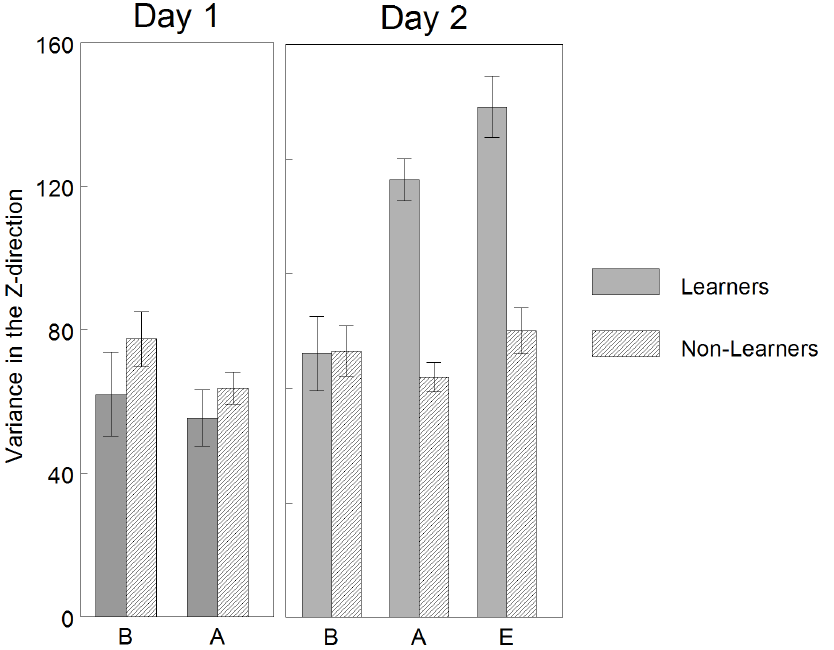
Figure 7. Learners versus non-learners: mean variance in the vertical, task specific direction, by condition. Between-groups, the Learners in comparison to the Non-Learners did not demonstrate a difference in variance during any condition of Day 1, but demonstrated a significant increase in variance during the acquisition and extinction conditions of Day 2. Within-group, the Learners did not demonstrate a significant change in variance between Day 2 baseline and Day 1 baseline (memory criteria), but did demonstrated a significant increase in variance between Day 2 acquisition and Day 1 baseline (learning criteria). Within-group, the Non-Learners did not demonstrate a significant difference in variance between Day 2 baseline and Day 1 baseline (memory criteria) or Day 2 acquisition and Day 1 baseline (learning criteria). This can be interpreted as the Learner group increased their variance when interacting with the mobile on Day 2 as compared to baseline kicking on Day 1. The Non-Learner group did not demonstrate a change in variance across days. Error bars are standard error. B=baseline, A=acquisition,